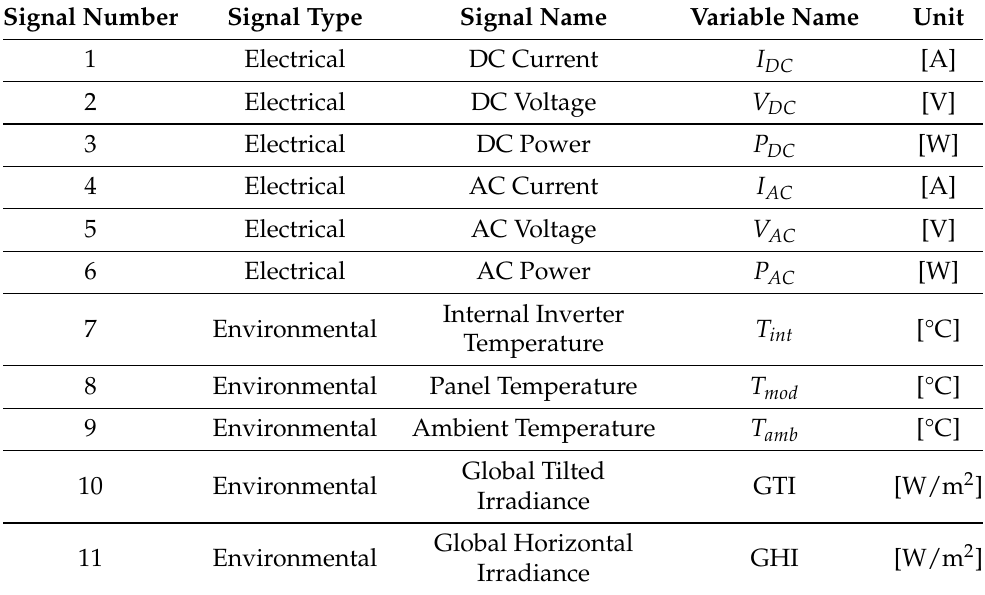
Table 2. List of electrical and enviromental signals used as input tags. T int is only available for plant